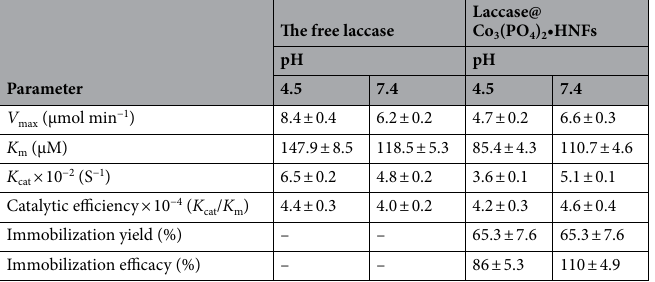
Table 2. Kinetic parameters of the free laccase and laccase@Co 3 (PO 4 ) 2